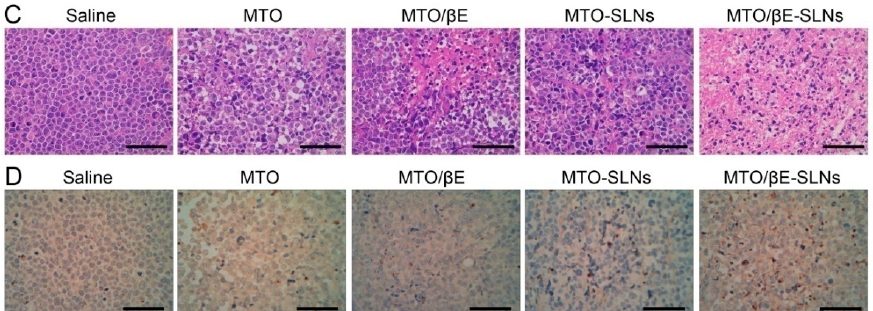
Figure 6. In vivo antitumor efficacies of various MTO formulations in K562/DOX tumor-bearing nude mice. ( A ) The tumor volume changes during the treatment with various formulations. Data are presented as means ± SD, n = 5. * p < 0.05; ** p < 0.01;*** p < 0.001. ( B ) The photograph of excised tumors harvested from each group at the end of the experiment. ( C ) Hematoxylin and eosin (H&E) assays of tumors from K562/DOX tumor xenografts-bearing BALB/c nude mice after being subjected to different treatments for 18 days. Scale bar = 200 μ m. ( D ) TdT-mediated dUTP nick-end labeling (TUNEL) assays of tumors from K562/DOX tumor xenografts-bearing BALB/c nude mice after being given different treatments for 18 days. Scale bar = 200 μ m.